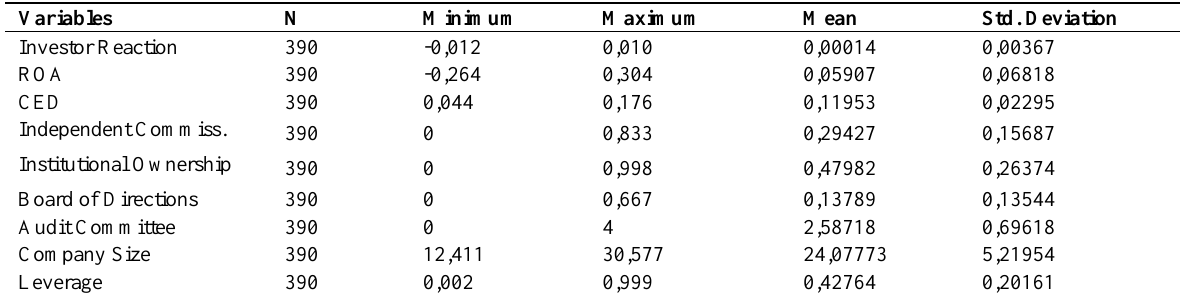
Table 3: Descriptive statistics